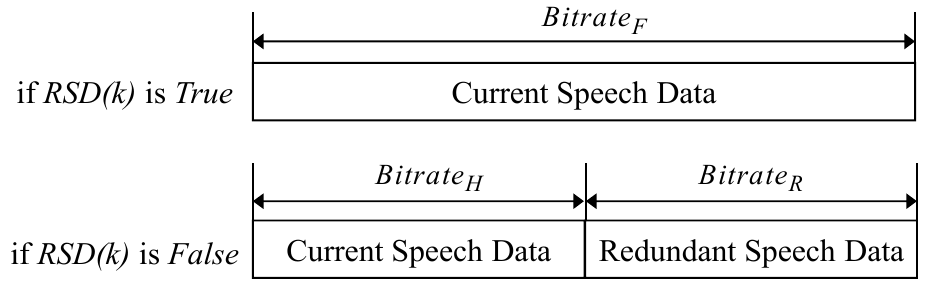
Figure 8. Bitrate assignment according to the RSD